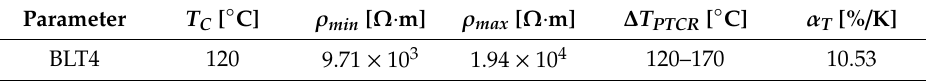
Table 4. Values of posistor parameters of BLT4